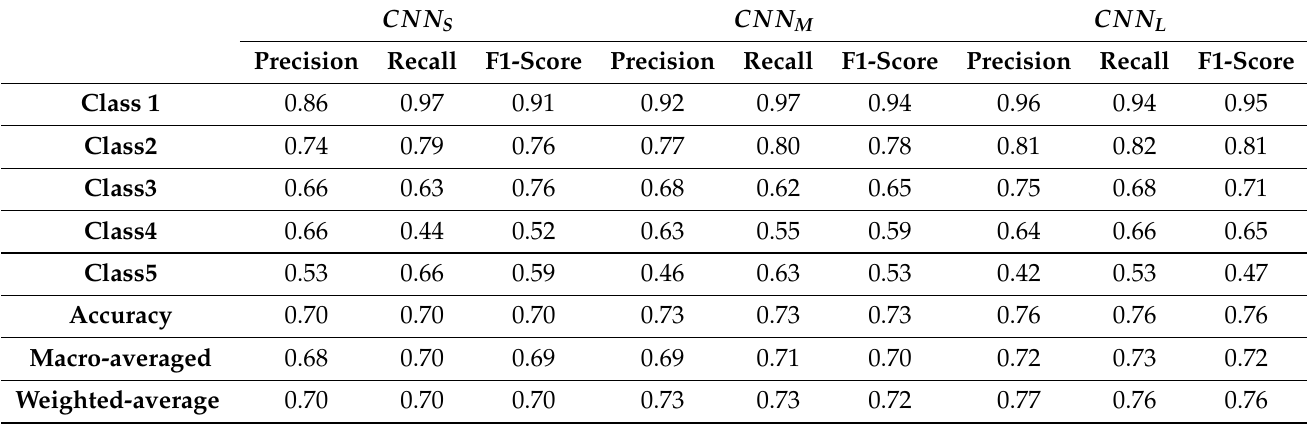
Table 2. Patch-wise classification accuracy for our proposed CNN S and CNN L using precision, recall, F1-score, accuracy, macro-averaged, and weighted-averaged.